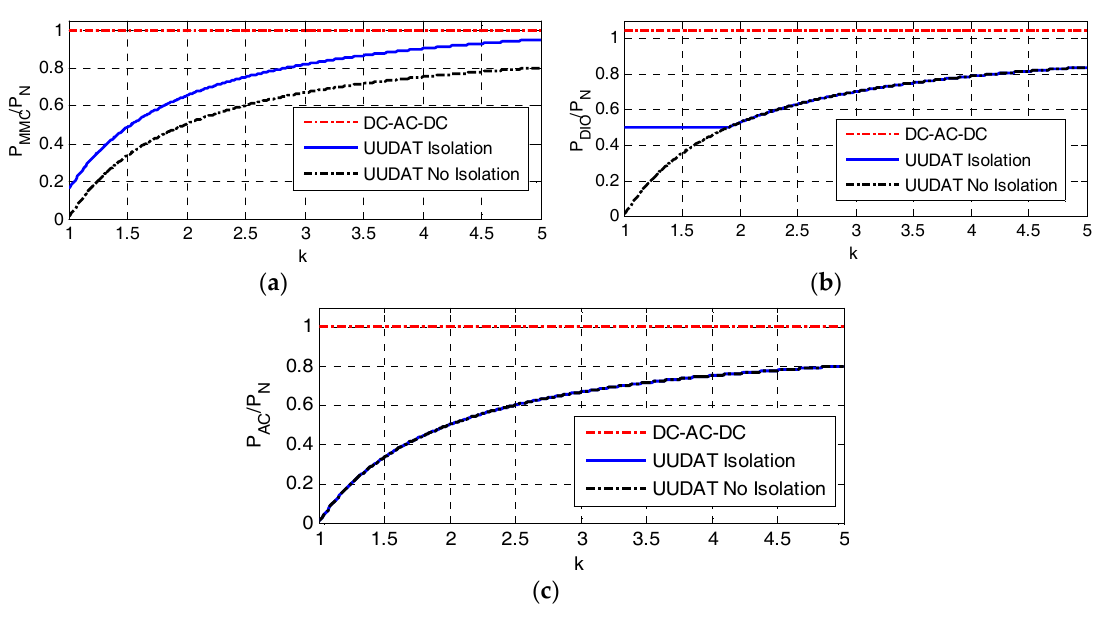
Figure 4. Power rating of MMC, un-controlled rectifier and AC transformer in a UUDAT versus stepping ratio. ( a ) Power rating of MMC; ( b ) Power rating of uncontrolled rectifier; ( c ) Power rating of transformer.